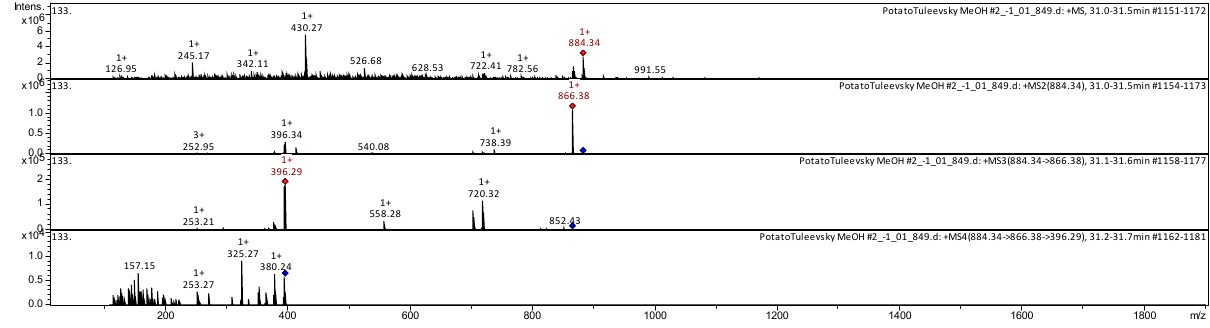
Figure 6. CID-spectrum of Dehydrochaconine [Solanidine dehydrodimer conjugated with chacotriose] from extracts of S. tuberosum (variety Tuleevsky), m / z 850.41.